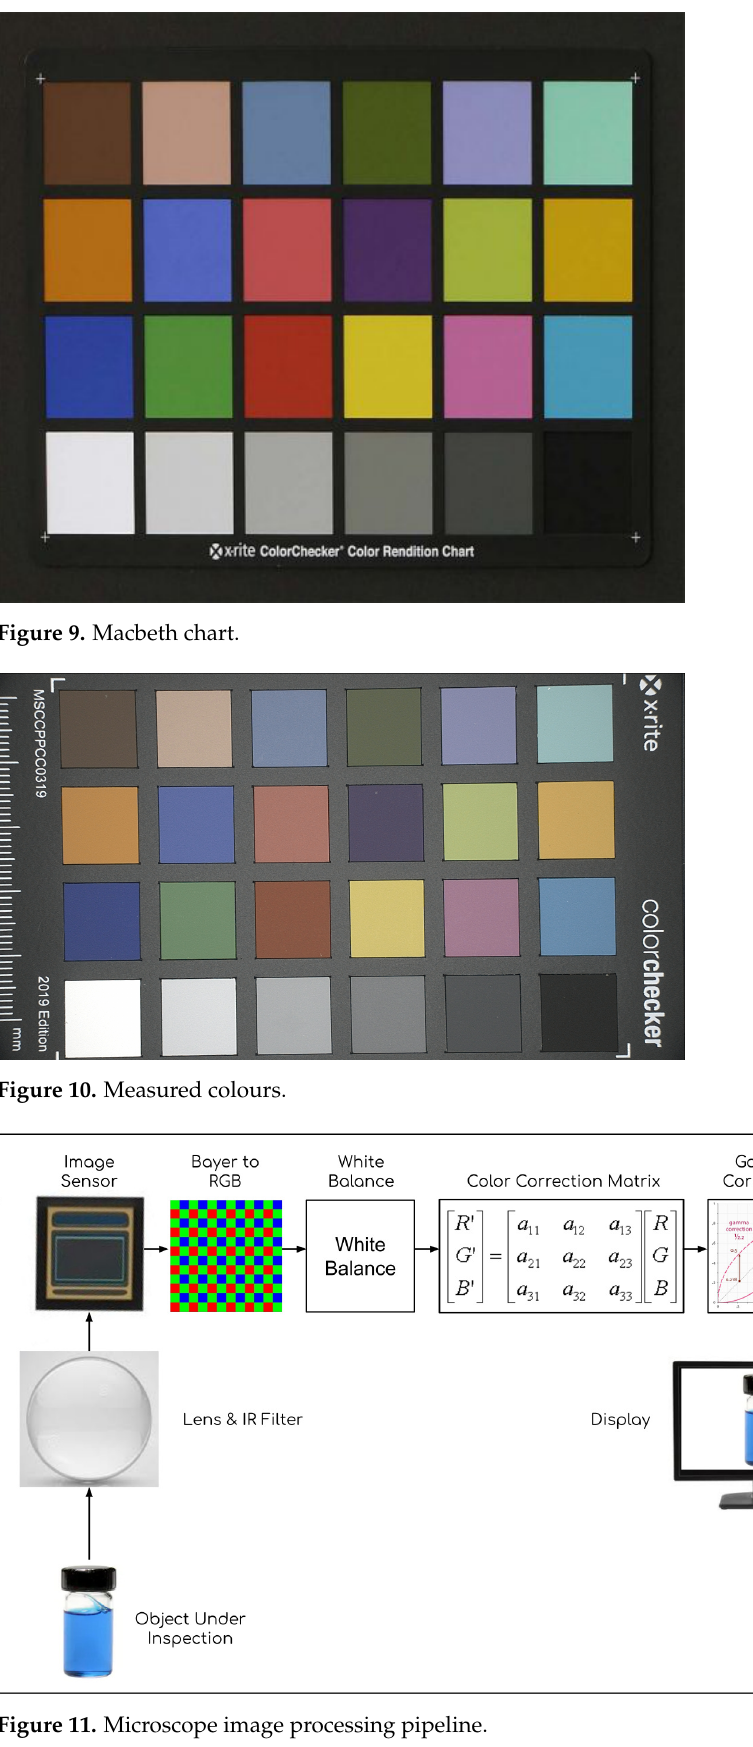
Figure 11. Microscope image processing